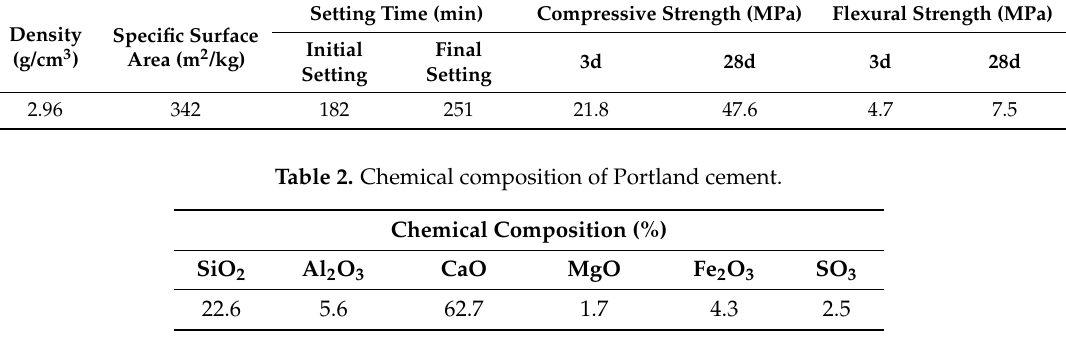
Table 1. Physical properties of Portland cement.